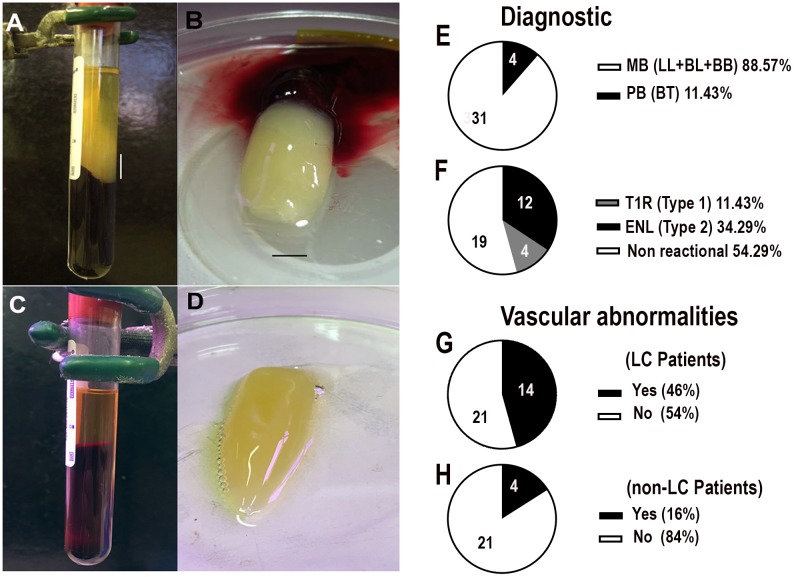
Leprosum clots formed during serum harvesting of multibacillary patient.A) Appearance of the leprosum clot during lepromatous patient serum harvesting, after blood coagulation and subsequent centrifugation. The vertical scale bar represents 2 cm and identifies the leprosum clot appearing on the top of normal erythrocyte-rich clot. B) The leprosum clot after PBS washing had a characteristic white-milky color. Scale bar represents 1 cm. C) Representation of a normal blood serum harvesting, after coagulation and subsequent centrifugation. D) Control clot aspect, formed from healthy donors’ plasma by the addition of calcium chloride; E) Leprosum clot distribution among 35 leprosy outpatients (11 females, 24 males; median age, 47.7 years; range, 10–76 years) discriminated by the clinical pole of the disease or presence/absence of reactional episodes (F). G) Vascular abnormalities occurrence in patients who developed leprosum clot during serum harvesting (LC patients) or not (H). MB: multibacillary patients, PB: paucibacillary patients, ENL: erythema nodosum leprosum and T1R: reversal reaction.